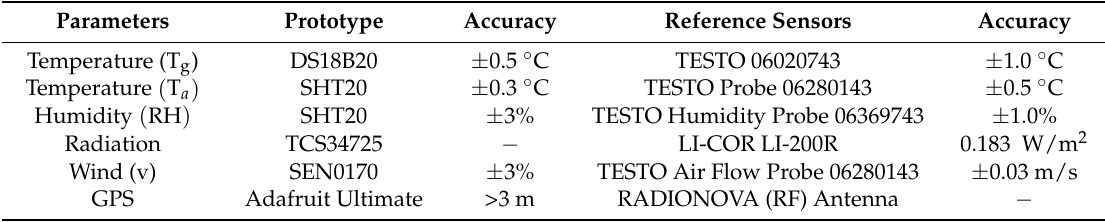
Table 2. Accuracy of components (prototype and reference sensors).